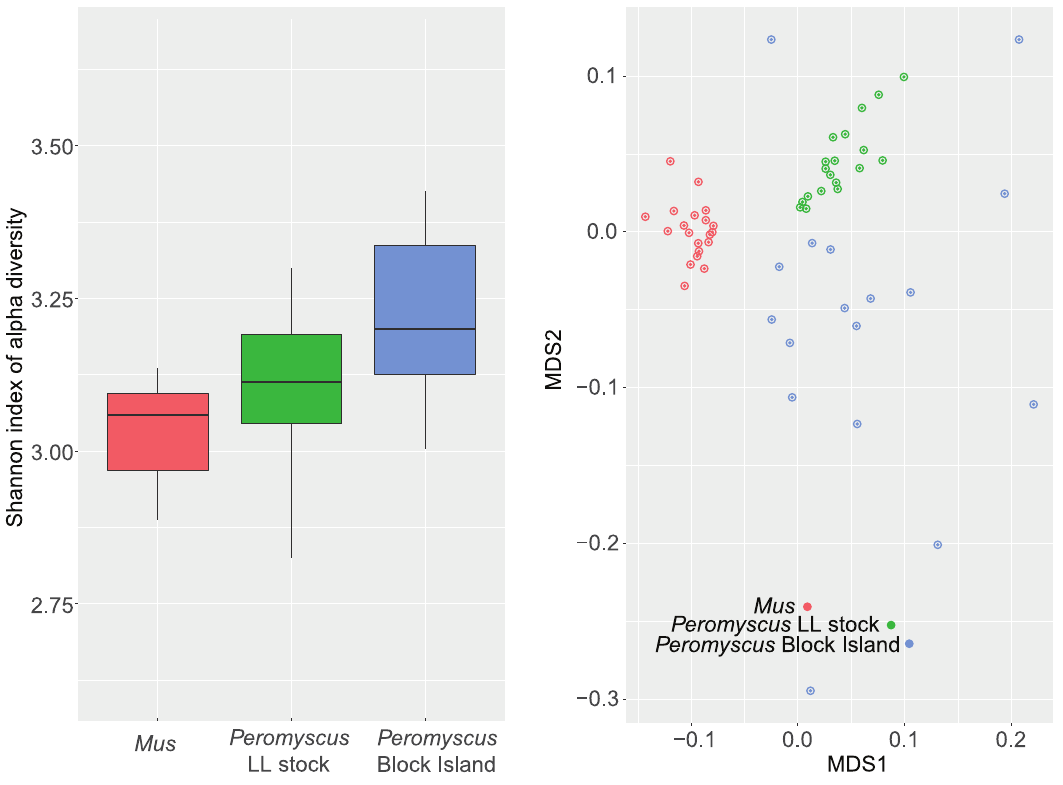
Fig 10. Alpha diversity (left) and beta diversity (right) of gut metagenomes of outbred Peromyscus leucopus (green), a natural population of P . leucopus (blue), and inbred Mus musculus (red). Left panel, box-whisker plots of Shannon index of alpha diversity for 20 BALB/c M . musculus , 20 LL stock colony P . leucopus , and 18 P . leucopus trapped on Block Island, RI. The 3 pairwise, 2-tailed t -test p values between the groups were � 0.02. Right panel, beta diversity by Bray-Curtis measure visualized by multi- dimensional scaling (MDS). A fuller description of the samples from the natural population from Block Island is provided below. The greater dispersion of values among these animals in panel B corresponded to the greater alpha diversity of this group (panel